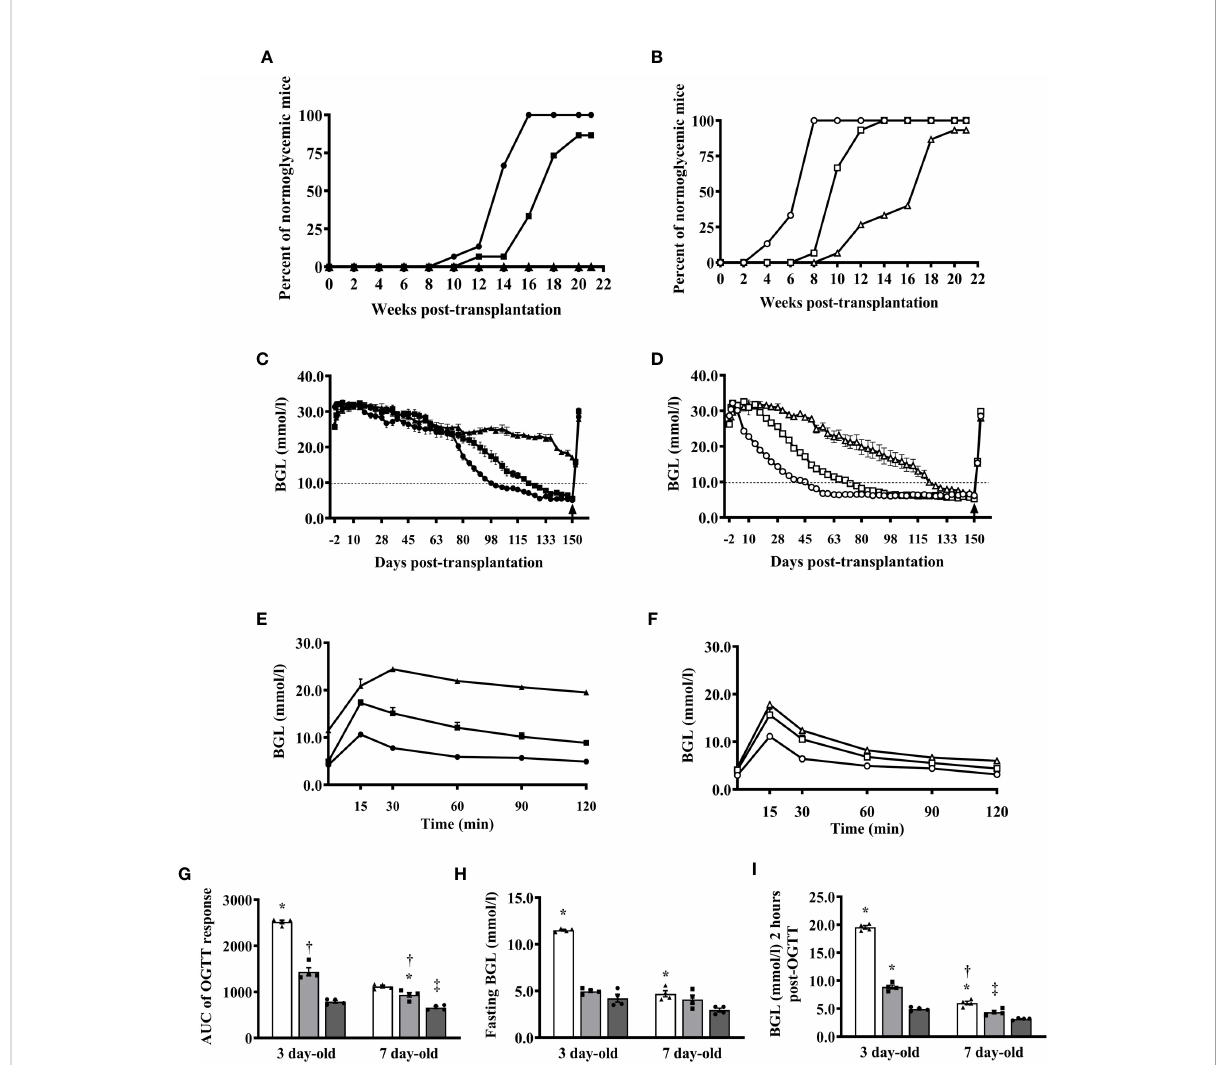
FIGURE 3 Reversal of diabetes in B6 rag-/- mouse recipients of various numbers of islets from 3- and 7-day-old pigs. (A) Proportions of mice transplanted with 500, 1000, and 2000 I.E. (n=15 per group) from 3-day-old pigs that achieved normoglycemia at various time points after transplantation. (B) Proportions of mice transplanted with 500, 1000, and 2000 I.E. (n=15 per group) from 7-day-old pigs that achieved normoglycemia at various time points post-transplantation. (C) Blood glucose levels of mice transplanted with various numbers of islets from 3-day-old pigs (n=15 per group). (D) Blood glucose levels of mice transplanted with various numbers of islets from 7-day-old pigs (n=15 per group). (E) Responses of B6 rag-/- mouse recipients of various numbers of islets from 3-day-old pigs after oral glucose challenge at >130 days after transplantation (n=4 per group). (F) Responses of mice transplanted with various numbers of islets from 7-day-old pigs post-oral glucose challenge (n=4 per group). Black and white symbols represent mice that received 500 (triangle), 1000 (square), and 2000 (circle) I.E. from 3- and 7-day-old pigs, respectively. (G) Calculated AUC responses of B6 rag-/- mouse recipients of islets from 3- and 7- day-old pigs after oral glucose challenge at >130 days post-transplantation. *p <0.0001, 500 I.E. vs. 1000 I.E and 2000 I.E.; † p <0.0005 between 1000 I.E. and 2000 I.E for 3-day-old and *p <0.005 between 1000 I.E. and 2000 I.E.; † p <0.05 between 500 I.E. vs. 1000 I.E.; ‡ p <0.0001 between 500 I.E. and 2000 I.E. for 7-day-old. (H) Fasting blood glucose levels of B6 rag-/- mouse recipients of islets from 3- or 7- day-old pigs. *p <0.0001 between 500 I.E. and 1000 I.E or 2000 I.E. for 3-day-old and *p <0.005 between 500 I.E. and 2000 I.E. for 7-day- old. (I) Blood glucose levels of B6 rag-/- mouse recipients of islets from 3- or 7-day-old pigs 2 hours post-glucose challenge. *p <0.0001, 500 I.E. and 1000 I.E. vs. 2000 I.E. for 3-day-old and *p <0.01, between 500 I.E. vs. 1000 I.E.; † p <0.0001 between 500 I.E. and 2000 I.E.; ‡ p ≤ 0.005 between 1000 I.E. and 2000 I.E. White (triangle), gray (square), and dark gray (circle) bars (symbol) represent data from B6 rag-/- mice that were transplanted with 500, 1000, and 2000 I.E., respectively (n=4 for each